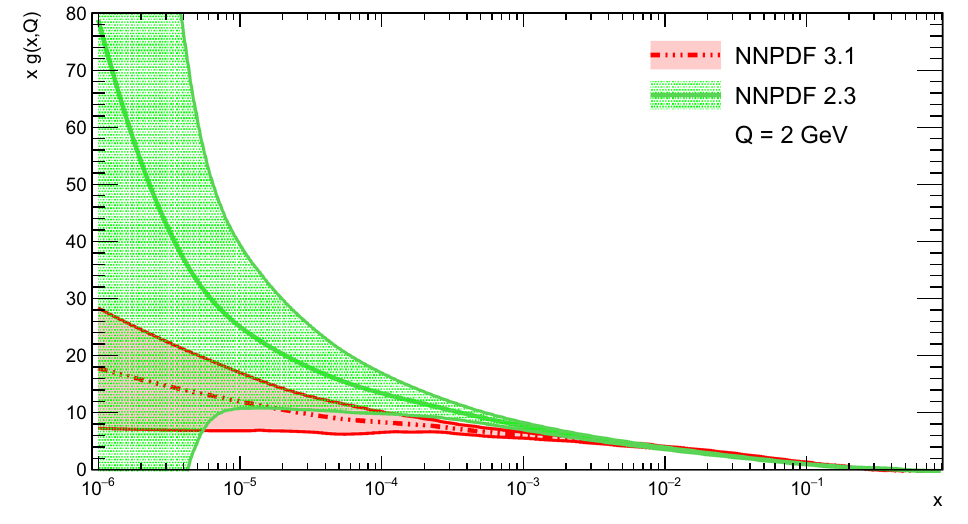
(b) Comparison of NNPDF 2.3 and 3.1 PDF sets showing 1 σ standard deviation. Fig. 2 A comparison of LO gluon distributions, xg ( x , Q = 2 GeV ) . Plots generated using the APFEL web interface